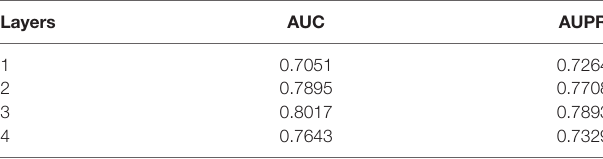
TABLE 2 | The performance of Deep-LC with different of GCN layers.